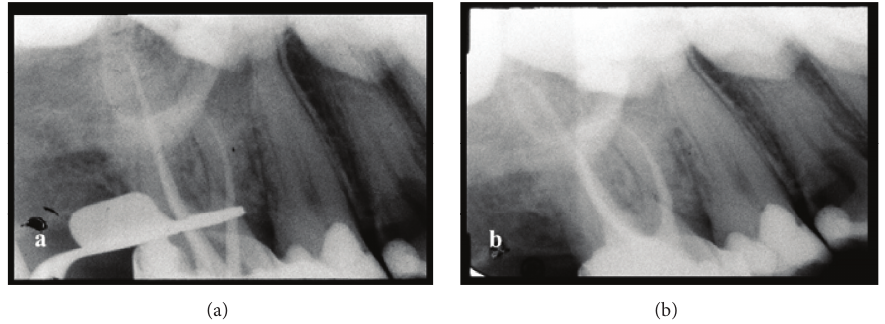
Figure 3: (a) Radiograph with the gutta-percha points: case report number 1. (b) Final radiograph: case report number 1.